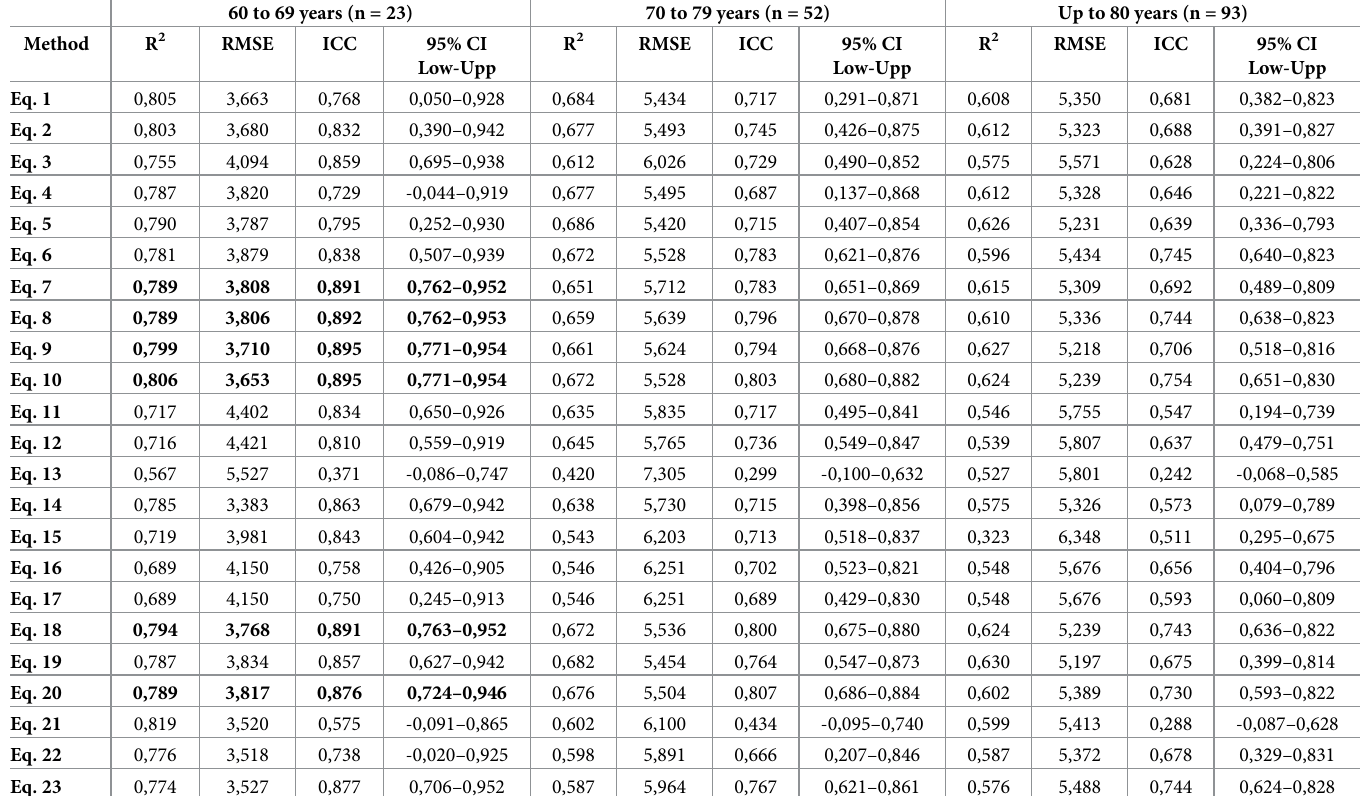
Table 5. Analysis of concordance of observed and estimated height of elderly living in nursing homes stratified by age group, Brazil,